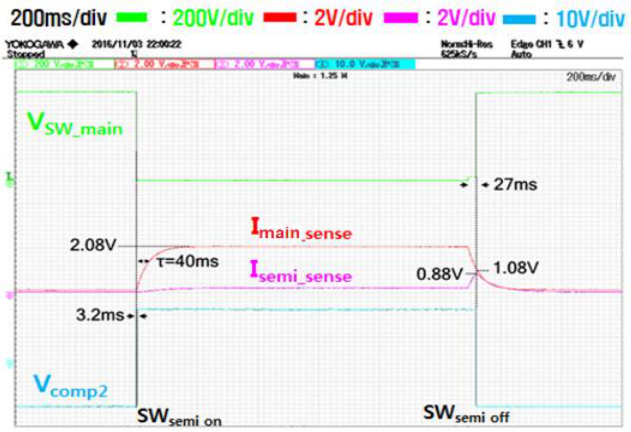
Figure 7. Output of Comparator 2 (V comp2 ) to turn on/off the semiconductor switch. When the main switch is turned off to break the circuit, the current flowing through the main switch branch is commutated by the commutation capacitor, and transfers to a semiconductor switch string branch and rapidly becomes zero. However, the current de- tection value of the main switch branch (I main_sense ) decreases gradually with a time delay of about 44 ms by the LPF. On the other hand, the current detection value flowing through the semiconductor switch string branch (I SEMI_sense ) rises more slowly with a time delay with a time constant of 88 ms, which is twice of that. Due to this difference in time con- stant, after the load current flowing through the main switch branch transfers to the sem- ator 2 (V comp2 ) goes low, and the semiconductor switch string is turned off to complete arcless cutoff.